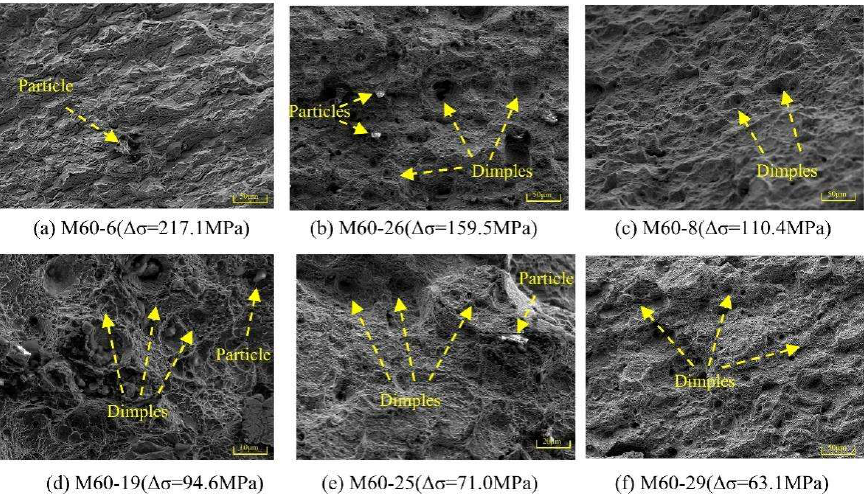
Figure 14. The microscopic morphology of the transient fracture region at different stress ampli- tudes.